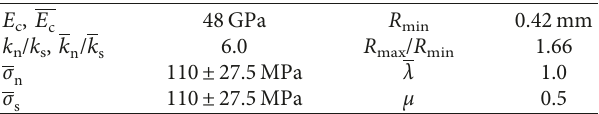
Figure 5: PFC model for strain burst. Table 3: Microparameters of the calibrated PFC model in the UC test and excavation wall model in the strain burst